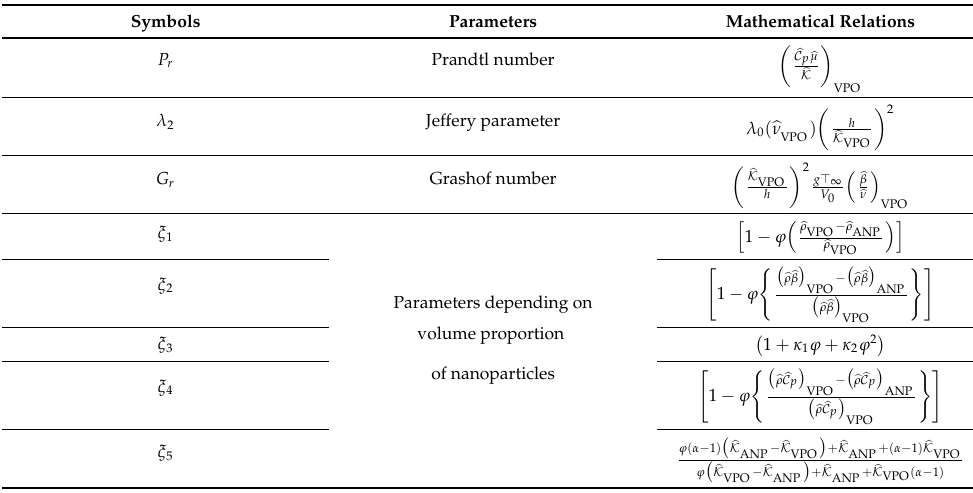
Table 2. Parameters appearing in Equations (8)–(13).